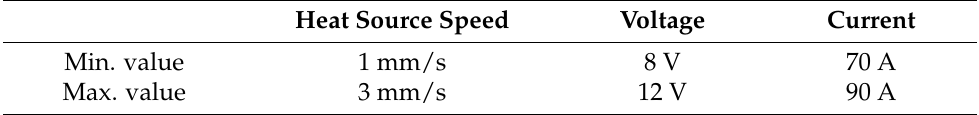
Table 3. Minimum and maximum values for the known parameters µ , as determined by the experts.